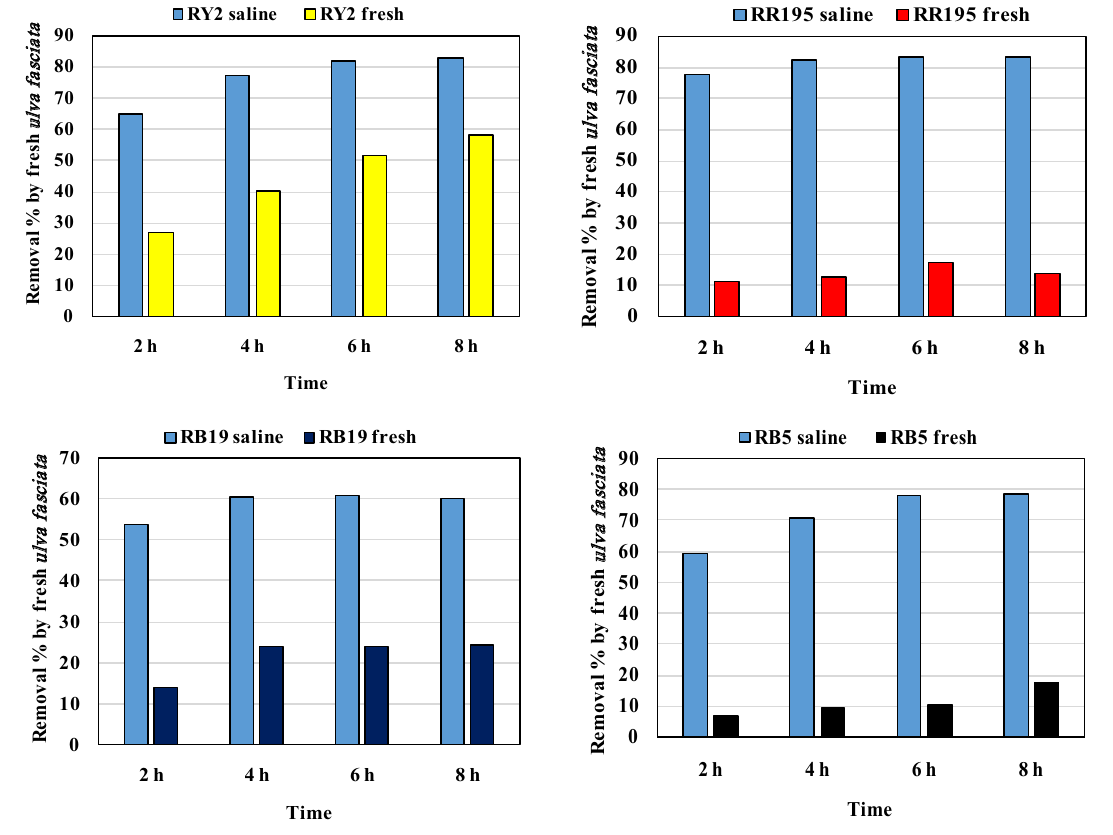
Fig. 9 Removal percentages of the four studied dyes by fresh Ulva fasciata under saline and fresh conditions Table 10 Removal percentages of the four studied dyes by fresh Pterocladia capillacea under saline and fresh